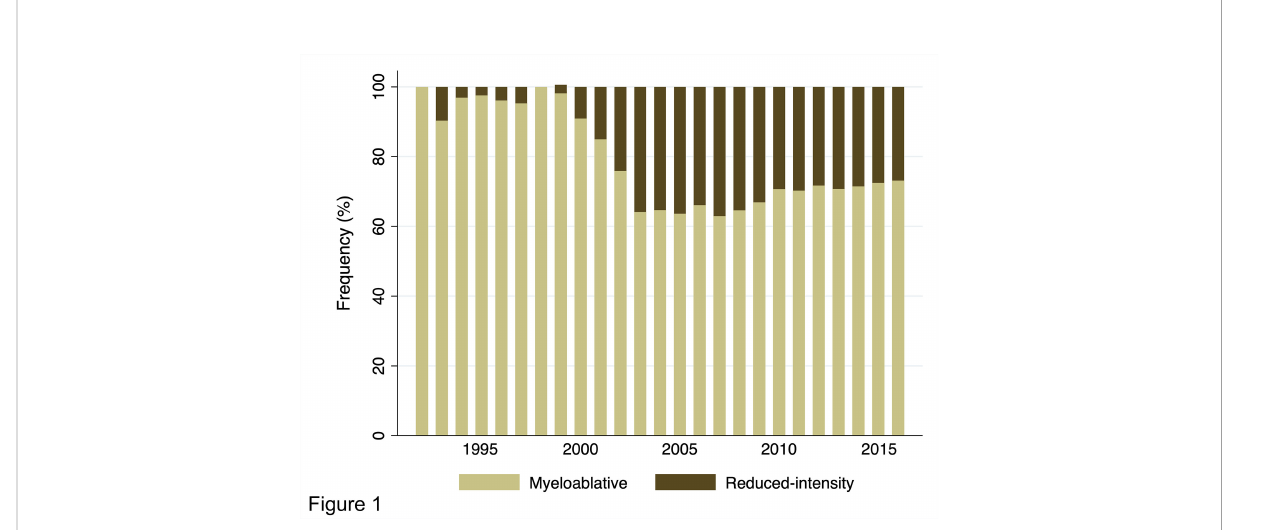
FIGURE 1 Annual trends in the distribution of conditioning intensity for adults with AML undergoing allogeneic HCT from 1992 to 2016 in